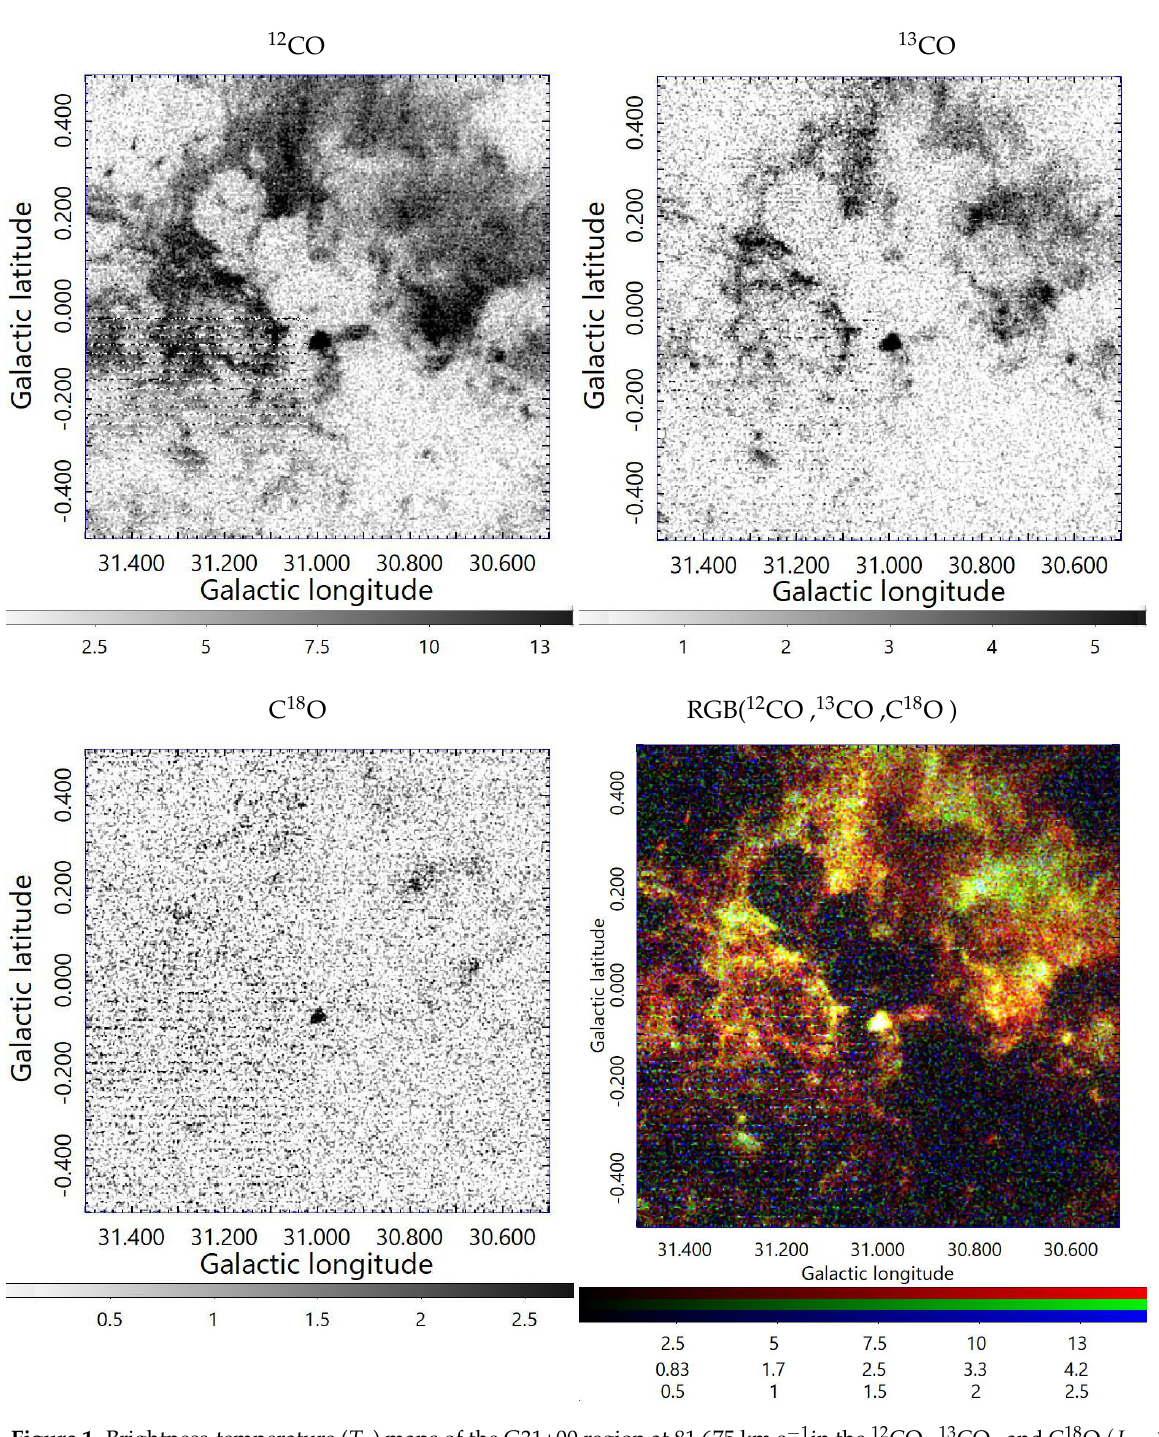
Figure 1. Brightness-temperature ( T B ) maps of the G31+00 region at 81.675 km s − 1 in the 12 CO , 13 CO , and C 18 O ( J = 1 lines, and a color-coded (RGB) map of 12 CO (red, 0– 15 K), 13 CO (green, 0–5 K), and C 18 O (blue, 0–3